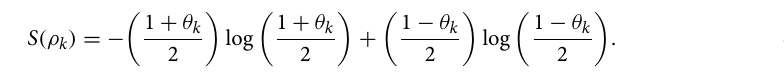
Figure 2. The concurrence and the QD between pair of spins on bonds with exchange coupling J ( a , c ) and J ′ ( b , d ). Lanczos results are presented for clusters with N = 20, 24, 28 spins and also DMRG results for N = 60, 90 . In panels ( e ) and ( f ), concurrence and QD are plotted for a cluster with N = 26 spins. At α = 1 , no difference between concurrences (or values of QDs) is